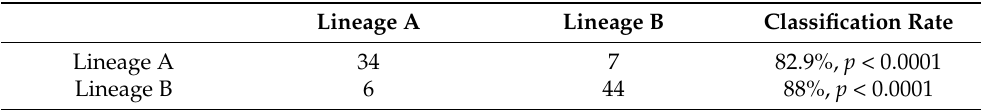
Table 3. Classification of individuals based on the PE mean shape comparison. The percentage indicates the correct classification rate of each group based on the cross-validation scores from discriminant function analysis (DFA).